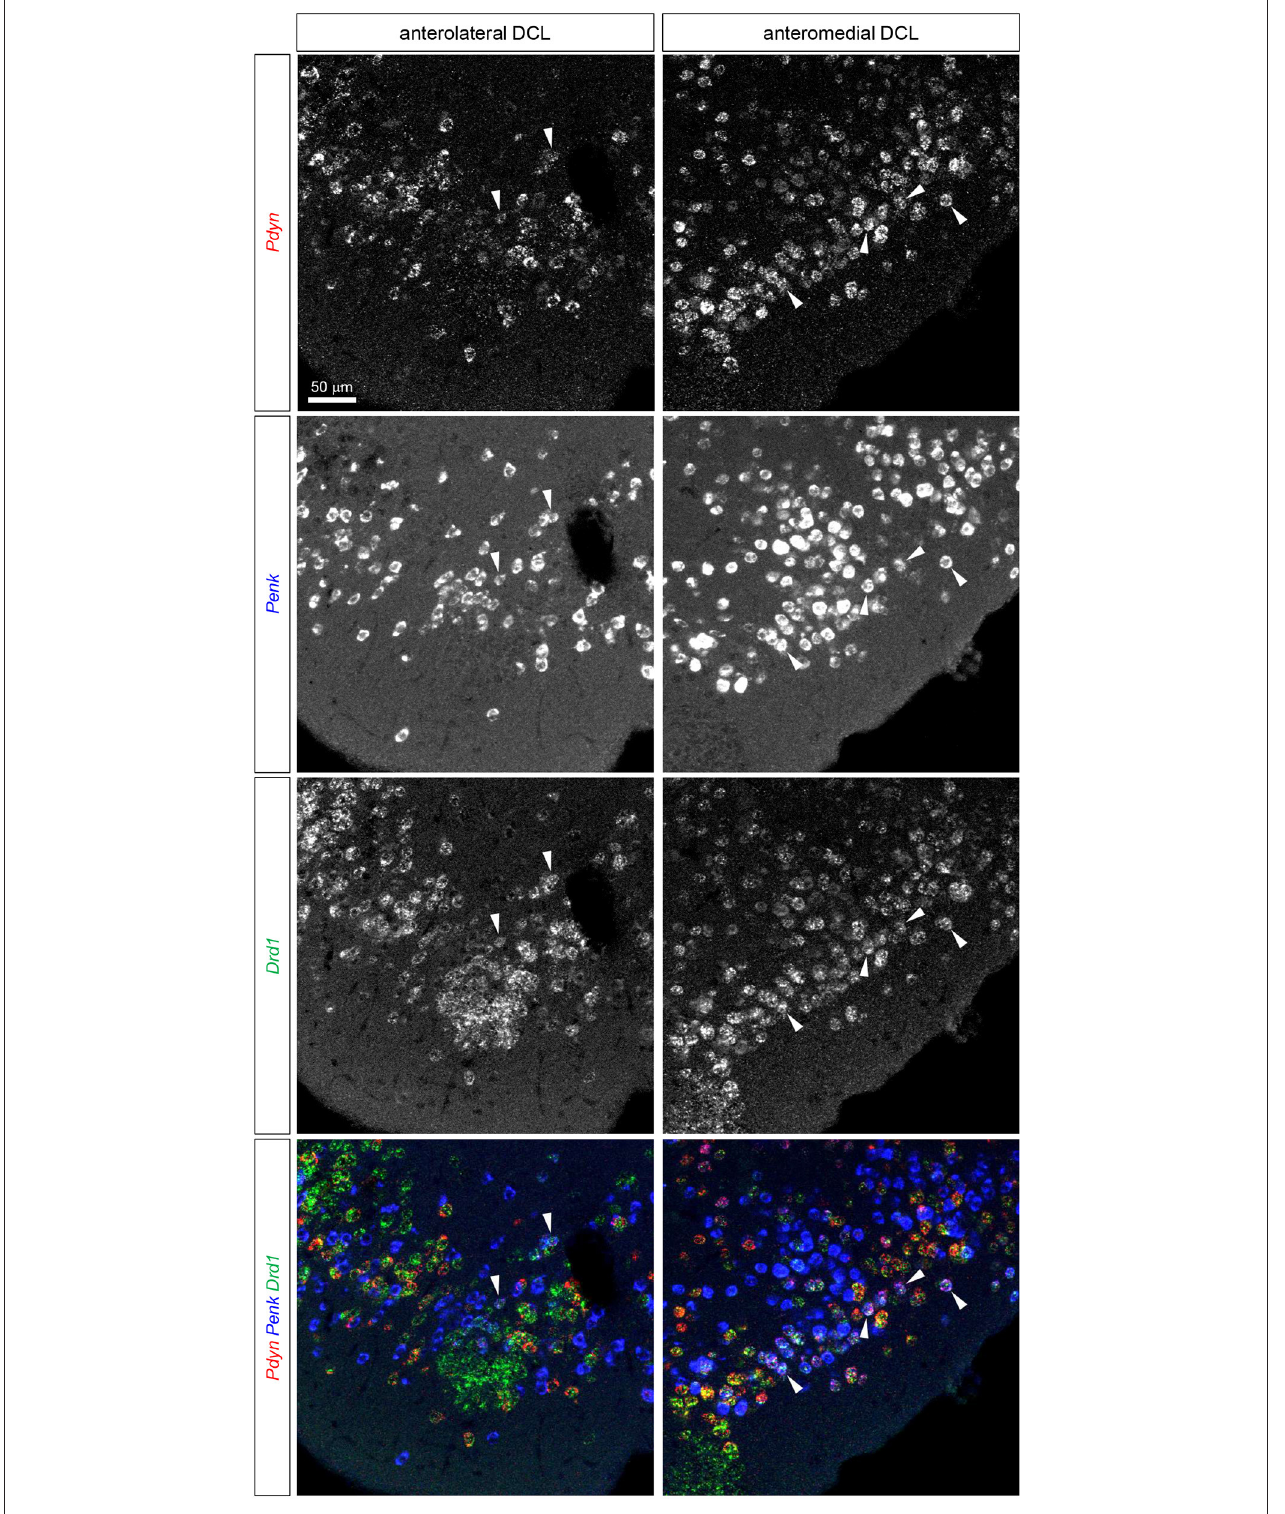
FIGURE 4 | Triple fluorescence ISH for Pdyn-Penk-Drd1 mRNAs in the anteromedial and anterolateral OT DCL. Fluorescence images of Pdyn (red), Penk (blue), and Drd1 (green) mRNA signals in the same region. White arrowheads show the colocalization of Pdyn-Penk-Drd1 mRNAs. Right panels, anteromedial DCL; left panels, anterolateral